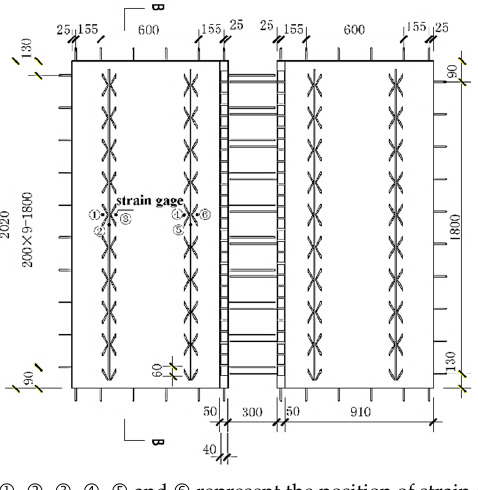
Figure 16. Lay − out of truss reinforcement strain gauges.